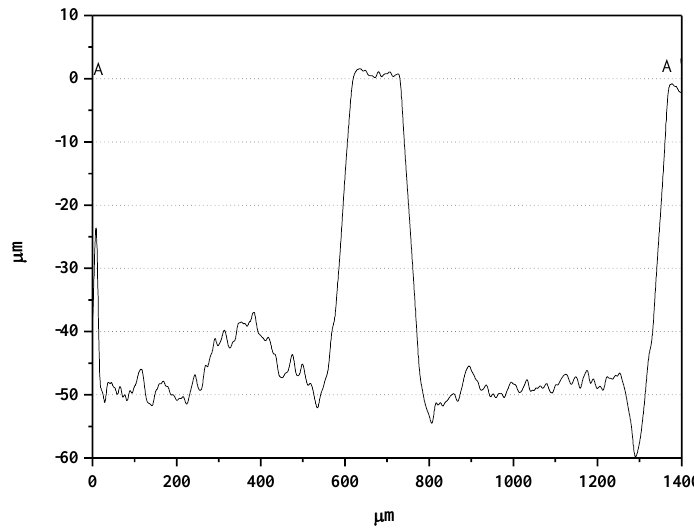
Figure 6. Surface profile of the cross-section of line AA’ in Figure 5a